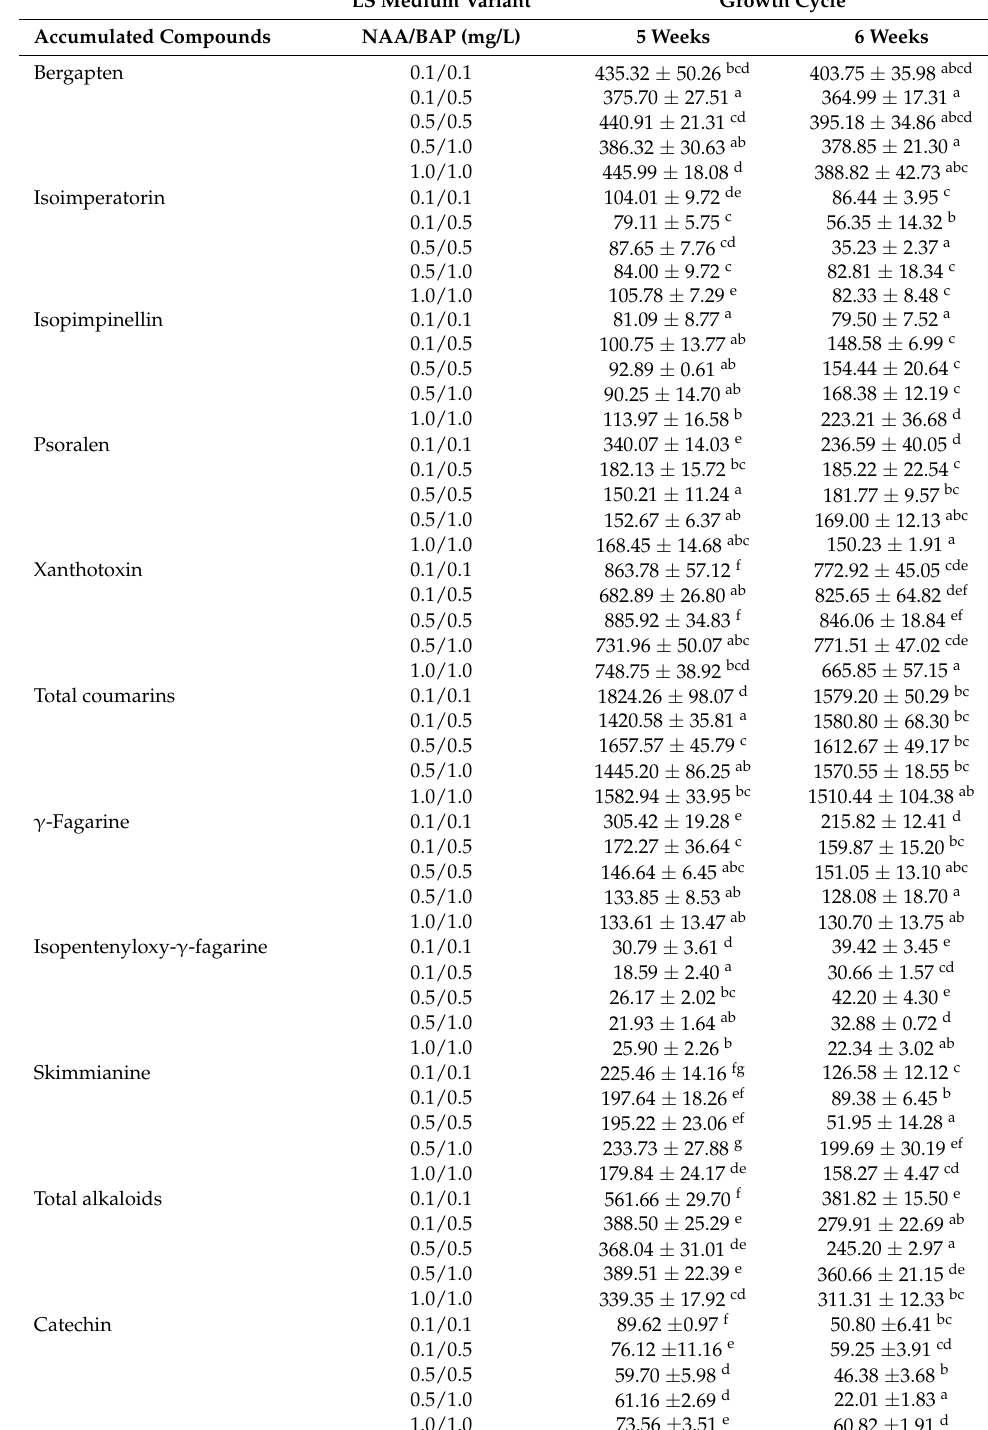
Table 2. Average content of metabolites [mg/100 g DW] in methanol extracts obtained from biomass of R. montana bioreactor cultures depending on the duration of the culture (5 and 6 weeks) growth cycle and LS medium